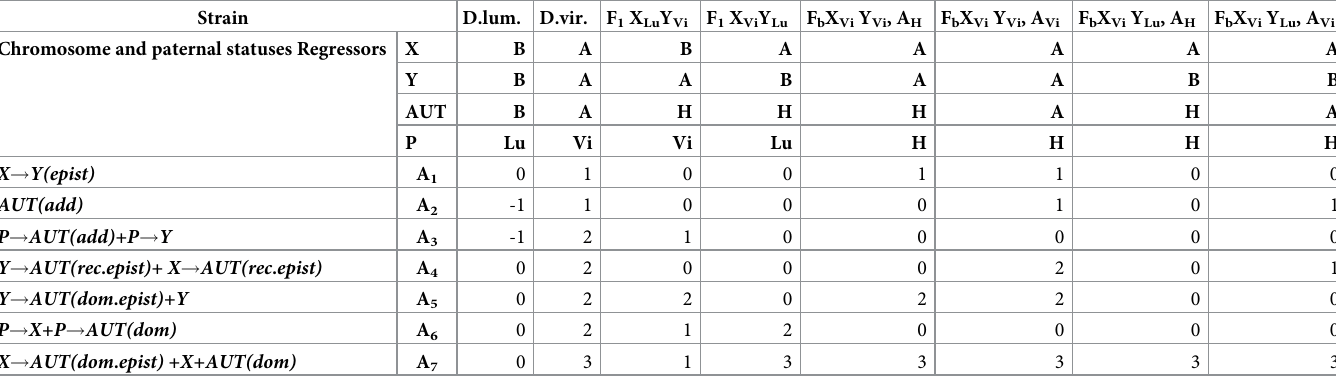
Table 2. Indicator variables used to obtain the coefficients of regression between hereditary factors or their combinations and trait values.